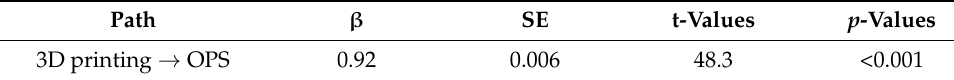
Table 10. Path validation between 3D printing and OPS.